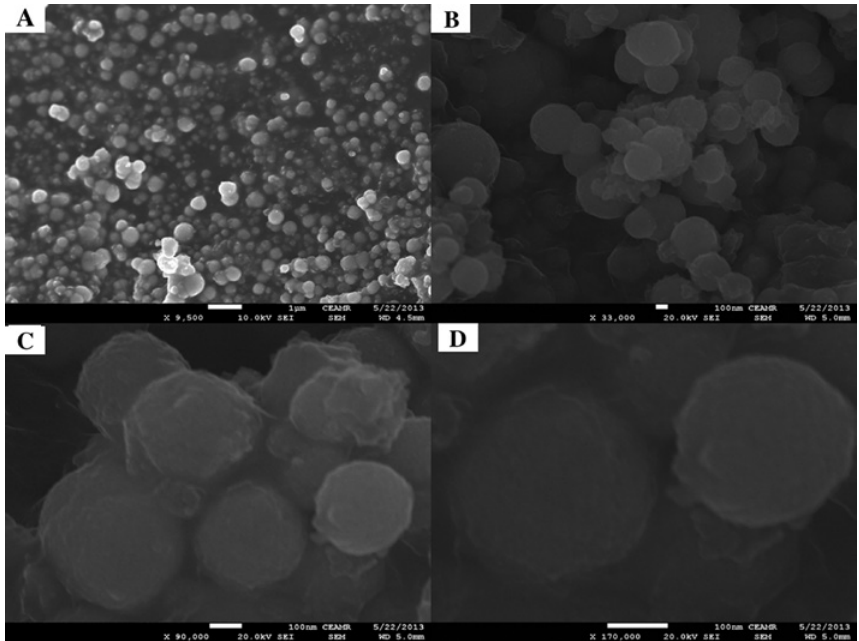
Figure 3: Low to high magnification FE-SEM images of prepared